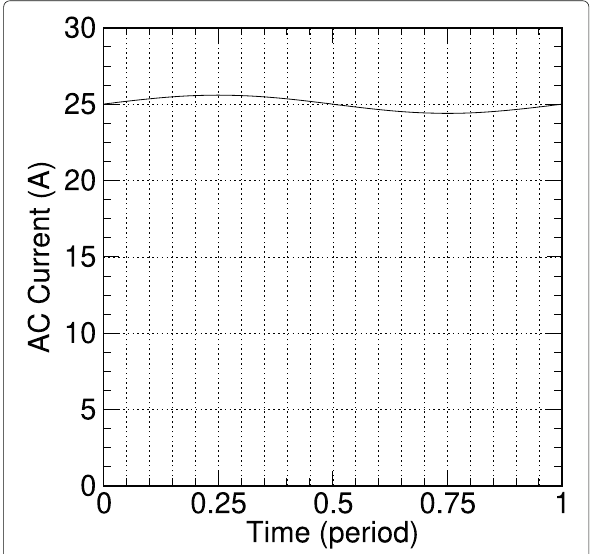
[29], the deviation angle during the switching was